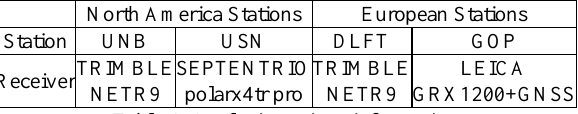
Table 1. Analysis stations information